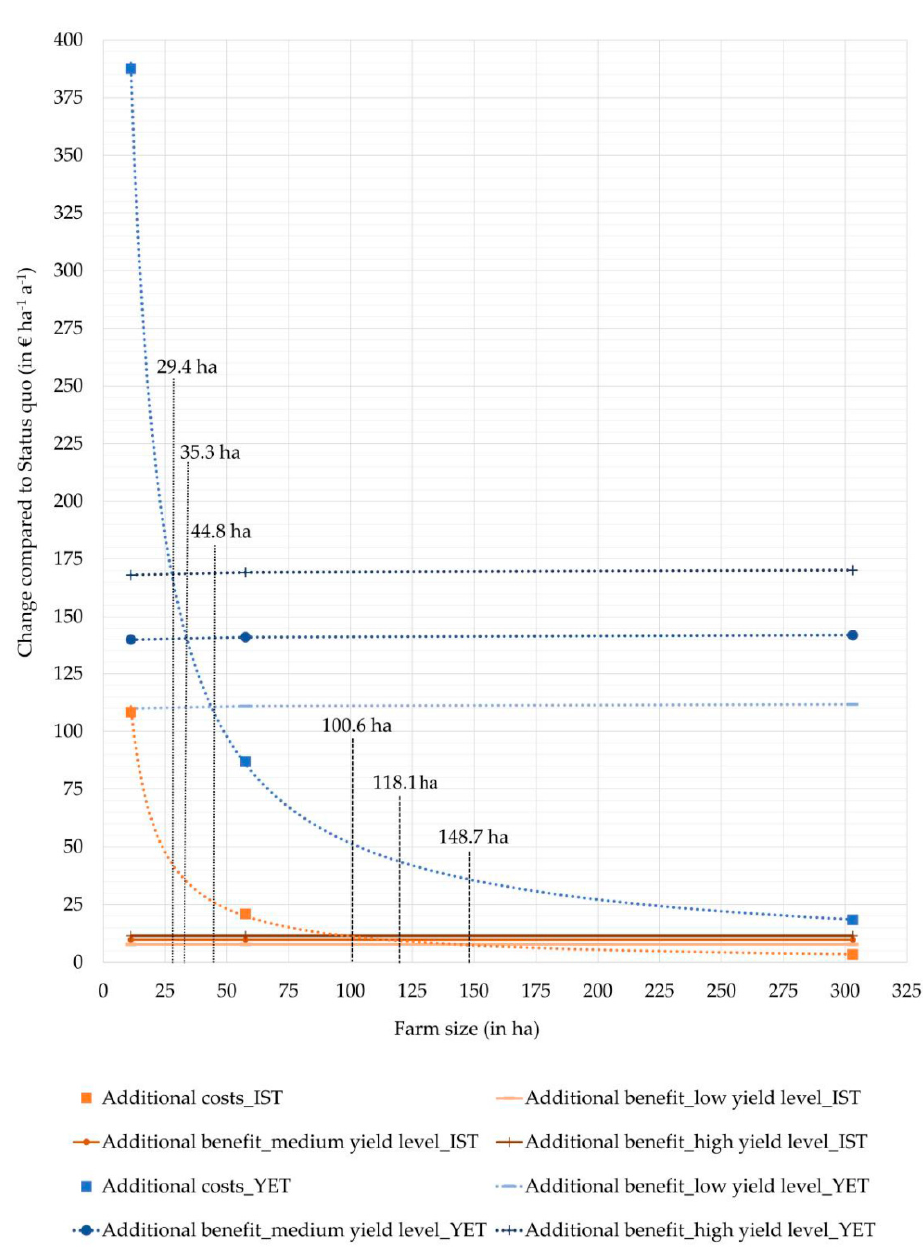
Figure 3. Different marginal farm sizes for the use of input-saving and yield-enhancing technologies at certain yield levels.